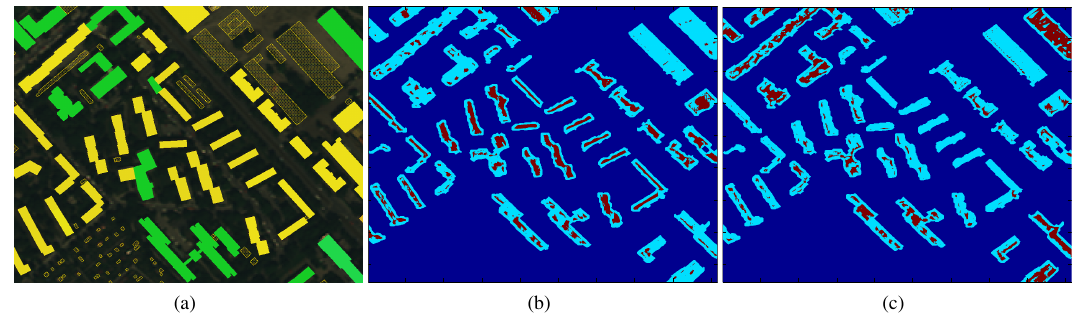
Figure 8: The ground truth (a), and demonstration of the areas in image J detected as pitched (b) and flat (c) roofs. In the ground truth pitched and flat roofs are depicted by yellow and green,